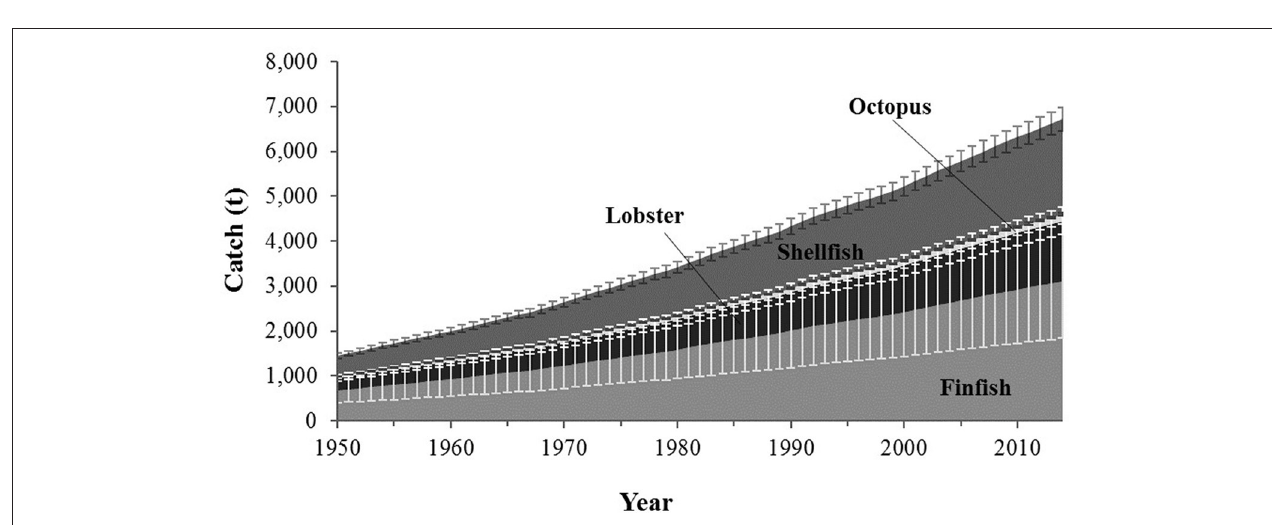
FIGURE 5 | Total reconstructed shallow water catches for export (i.e., artisanal) in Vanuatu, 1950–2014 by major taxonomic groups (all whole, wet weight).